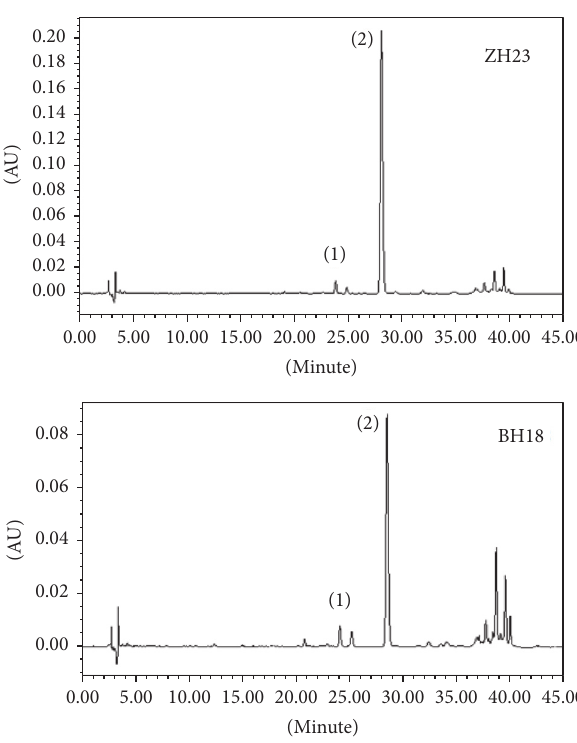
Figure 2: Elution profile of ZH23 and BH18 on the HPLC-UV chromatograms. The retention times for RA (1) and tanshinone Sal B (2) were 23.901 min and 28.303 min,